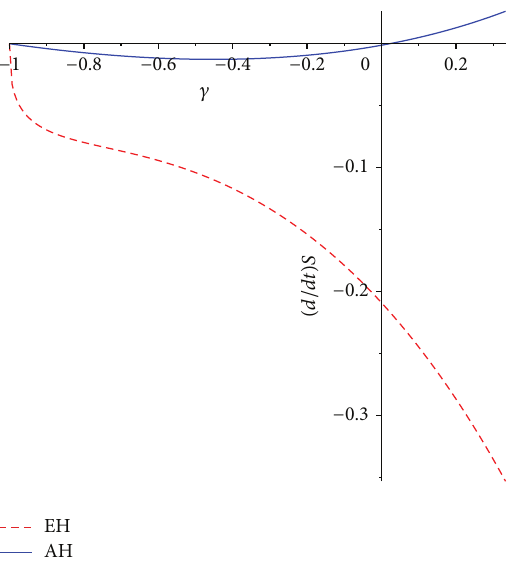
Figure 3: GSLT for RSII brane for Modified Chaplygin Gas.